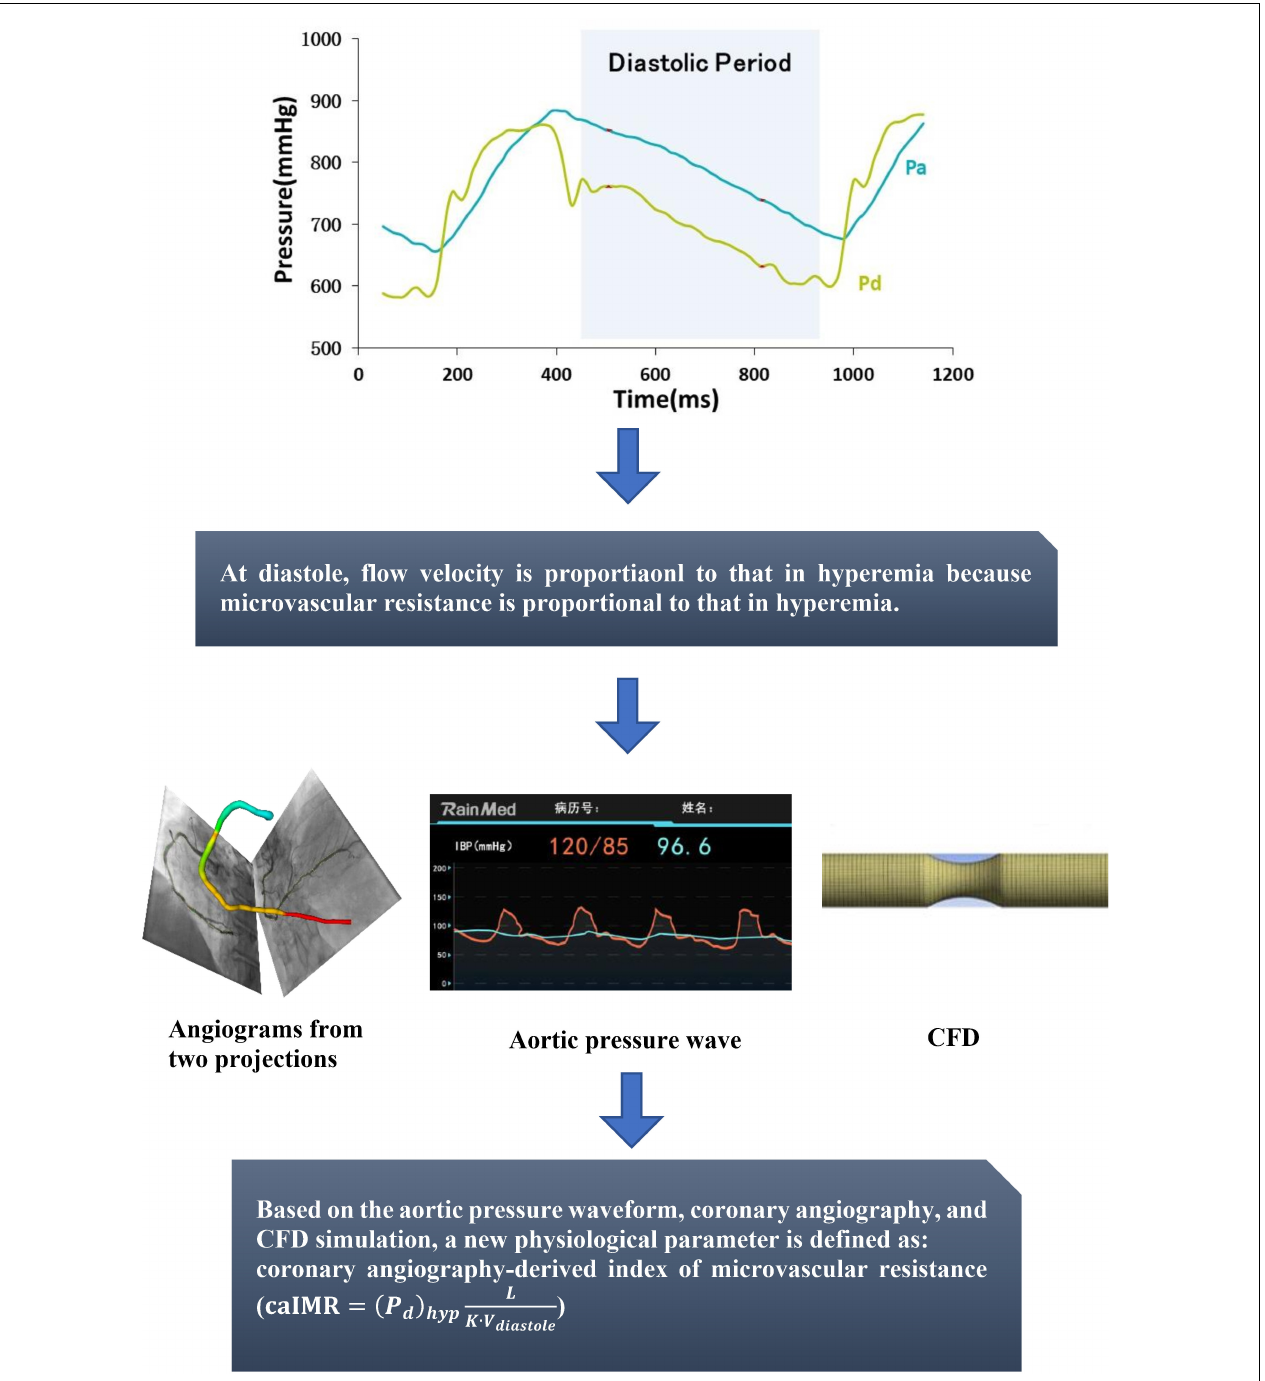
FIGURE 1 | Schematic representative performance of